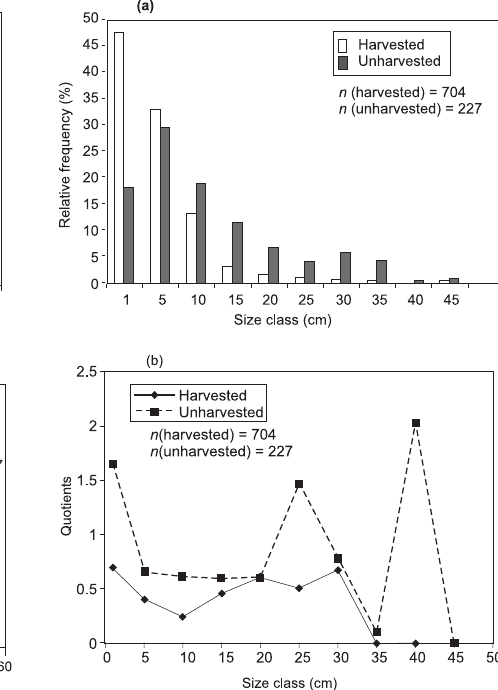
Fig. 2. Population structure of harvested and unhar- vested Catha edulis populations (a) relative frequen- cies and (b) quotients between numbers of trees in successive size classes.